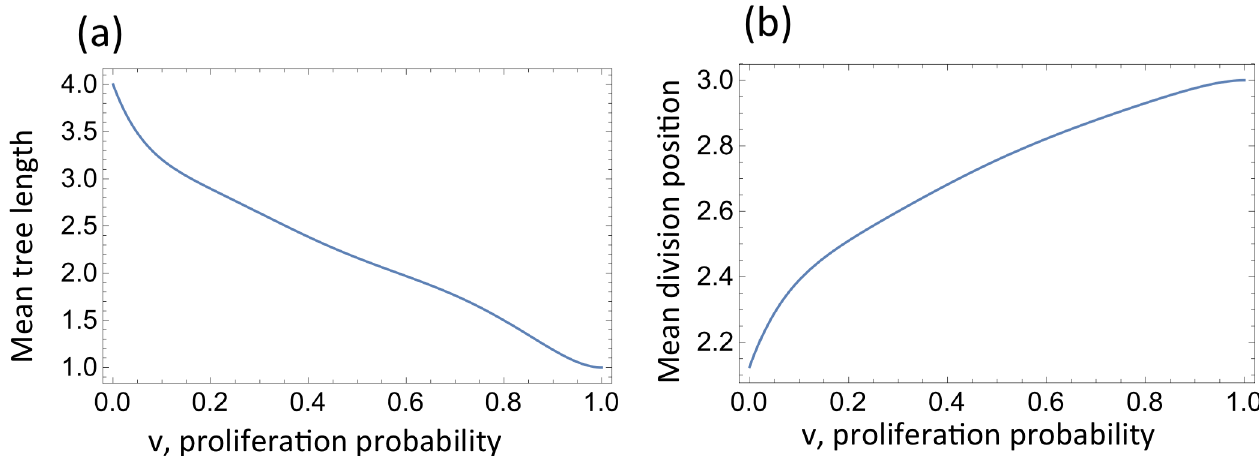
Fig 2. Properties of division trees as a function of v , the probability of self-renewal in compartments 1, ... , n − 1. (a) Mean tree length, defined as the mean number of compartments involved in the division trees. (b) Mean division position. For an individual tree, sequence (1), this is defined as P n 2 (cid:0) n 2 i ð a (cid:0) a Þ ; plotted is the expectation of this quantity across all the trees. In this example, n = 4. i i (cid:0) 1 i ¼ 0